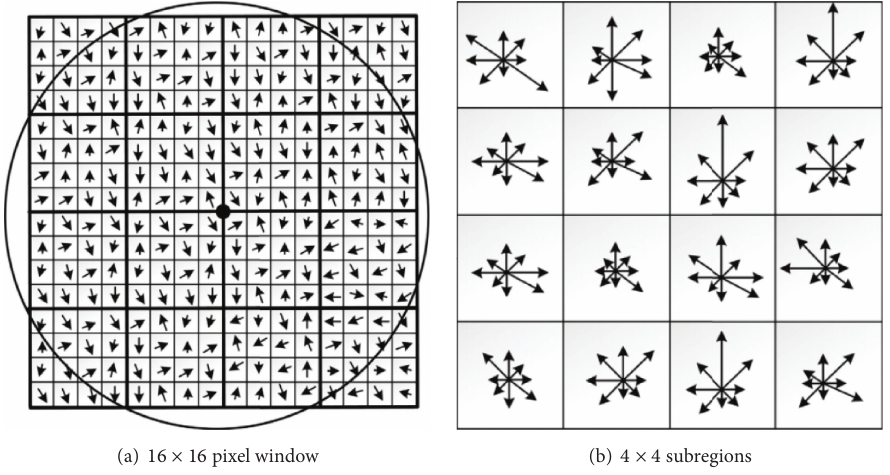
Figure 5: Image gradient and key point